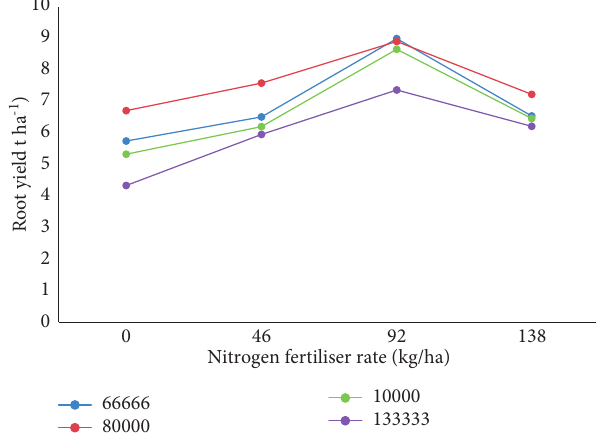
Figure 1: Interaction effects of plant density and nitrogen fertilizer rates on root yield (t ha − 1 ) of beetroot.